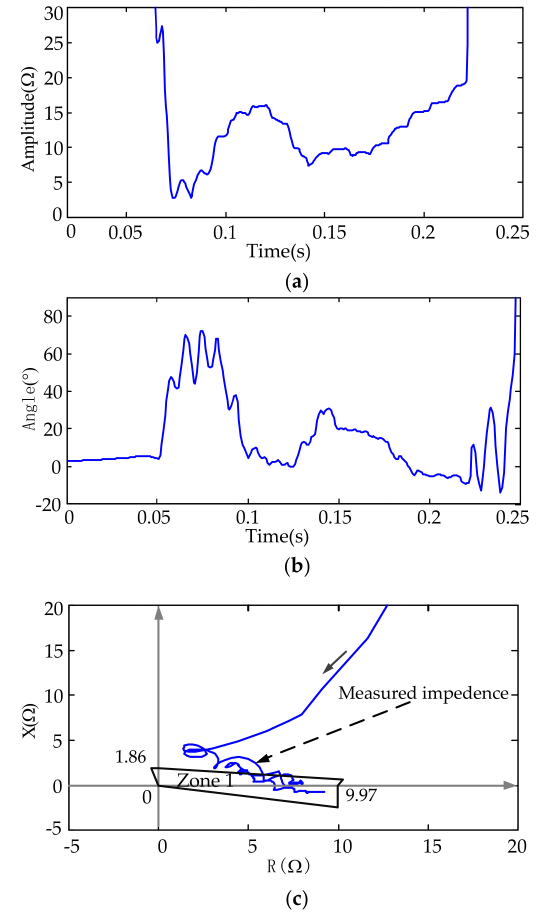
Figure 8. The phase-A-to-phase-B impedance of the wind farm side when a phase-A-to-phase-B fault occurs on the transmission line connected to a DFIG-based wind farm: ( a ) the amplitude of impedance; ( b ) the angle of impedance; and ( c ) the trajectory of